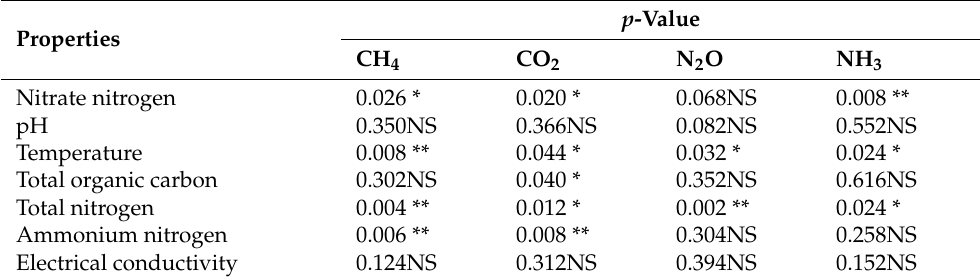
Figure 7. Redundancy analysis (RDA) between gaseous emissions and physicochemical indices of compost ( a ), methane ( b ), carbon dioxide ( c ) nitrous oxide and ( d ) ammonia. Table 2. Permutation results between gaseous emissions and physicochemical indices of